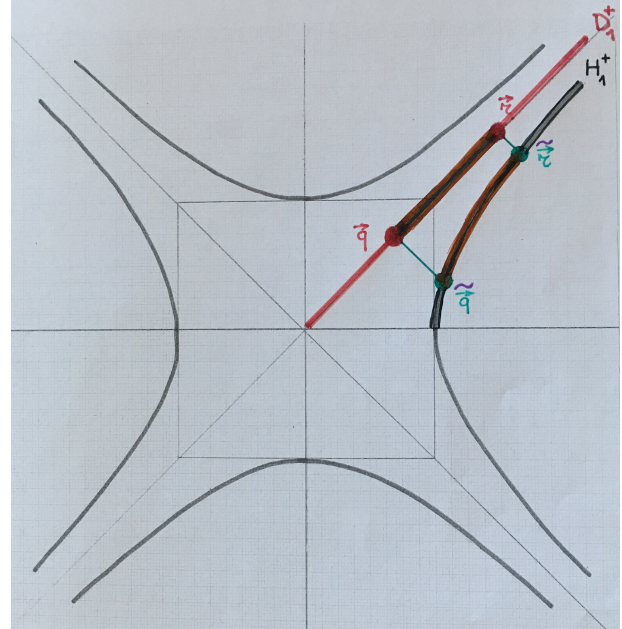
Figure 9. Minkowskian